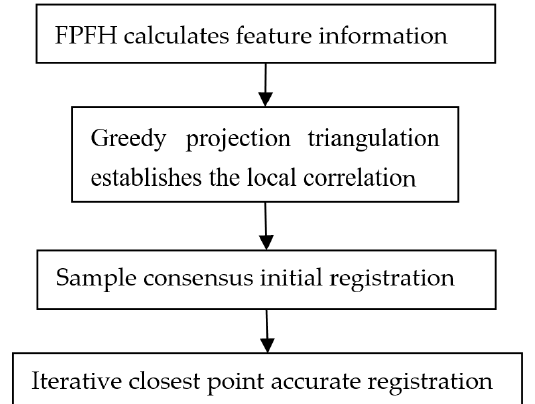
Figure 1. Point cloud registration chart. FPFH (fast point feature histograms).